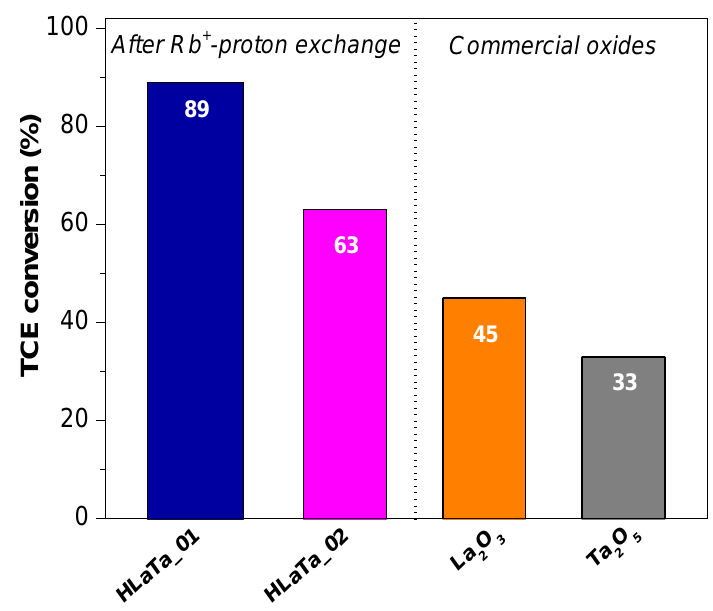
Figure 12. TCE conversion of HLaTa_01(02) photocatalysts and the commercial oxides.